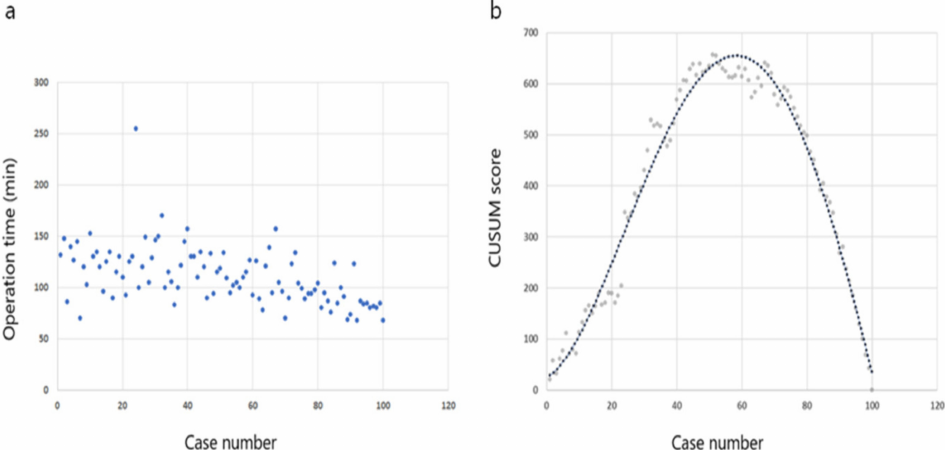
Figure 5. Operation time of lobectomy with transoral endoscopic thyroidectomy vestibular approach. ( a ) Operation time plotted in chronological order. ( b ) Cumulative summation test of operation